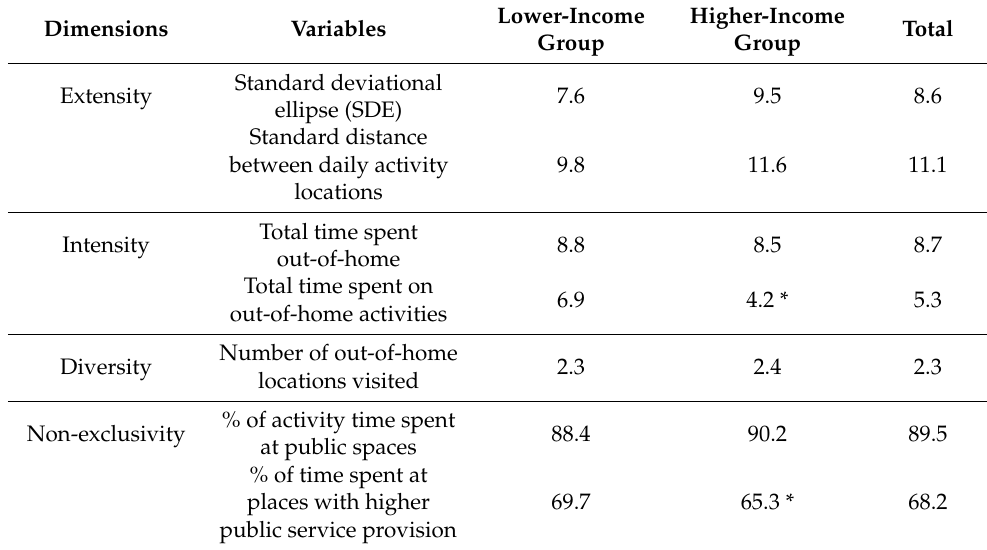
Lower-Income Group